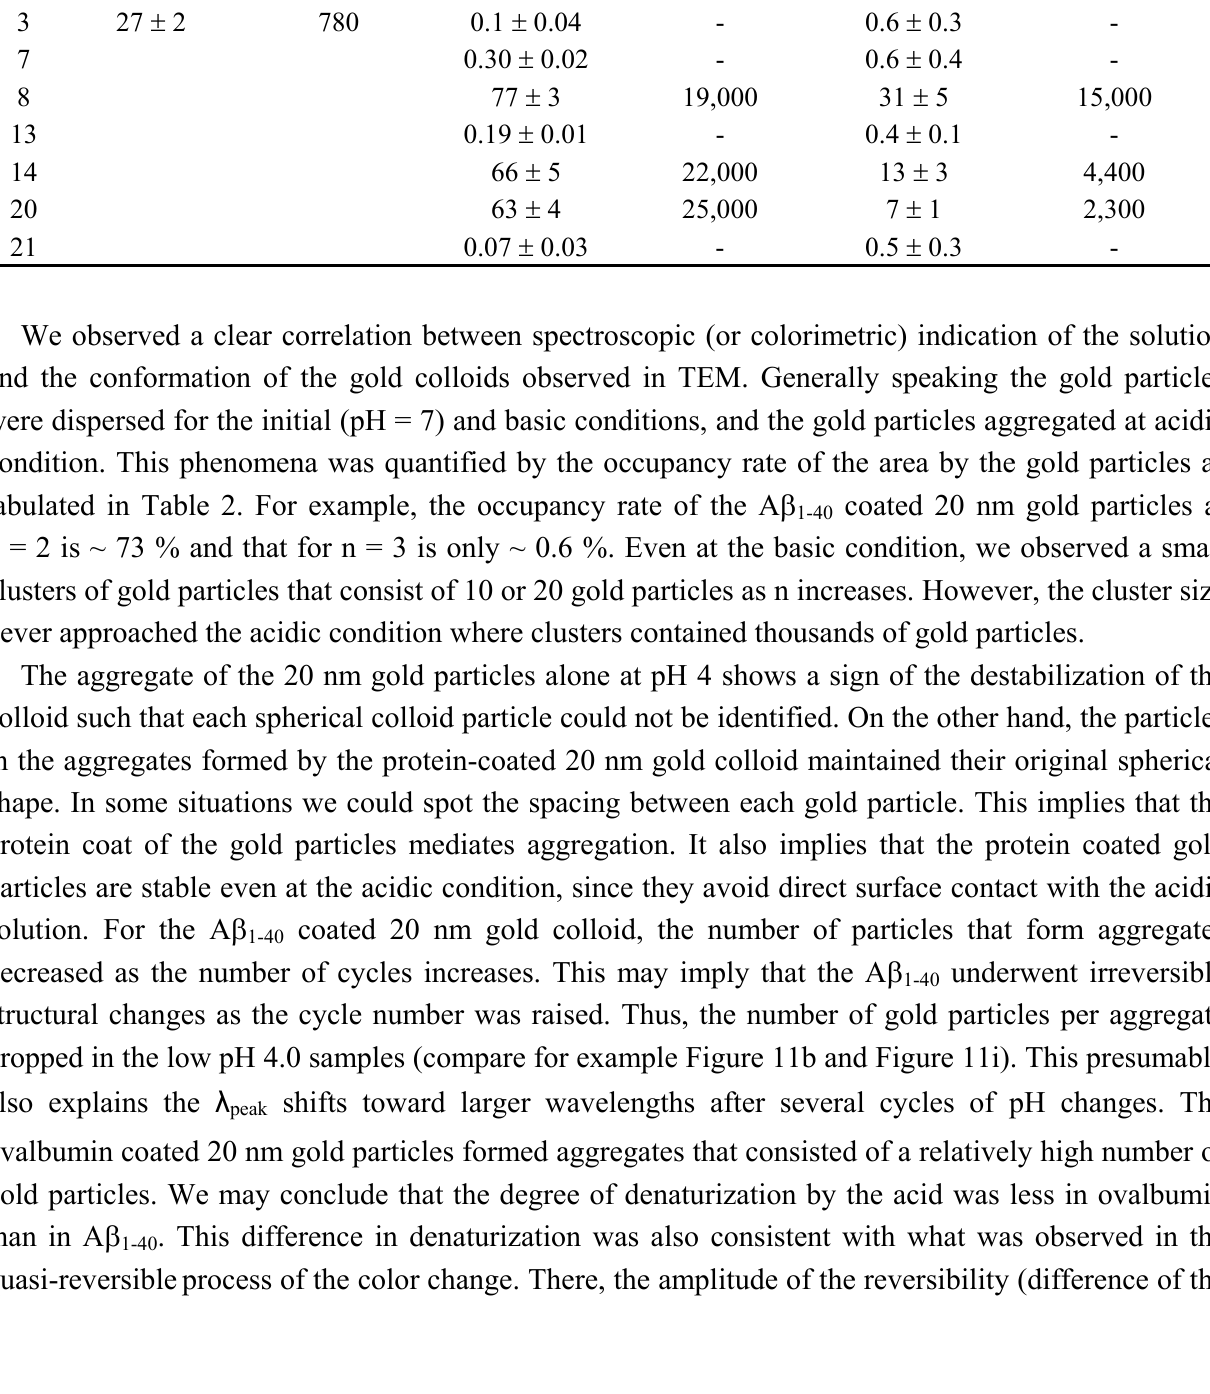
Table 2. The list of occupancy of the gold particles in a given area and number of gold particles in each aggregate for 20 nm gold particles, 20 nm gold particles coated with ovalbumin and 20 nm gold colloid coated with A  . The number of particles are shown 1-40 only when the solution is acidic condition where the aggregates are formed. Gold 20 nm coated with Gold 20 nm coated with Gold 20 nm ovalbumin A  1-40 Number of gold Number of gold Occupancy particles particles per gold particles (%) (%)